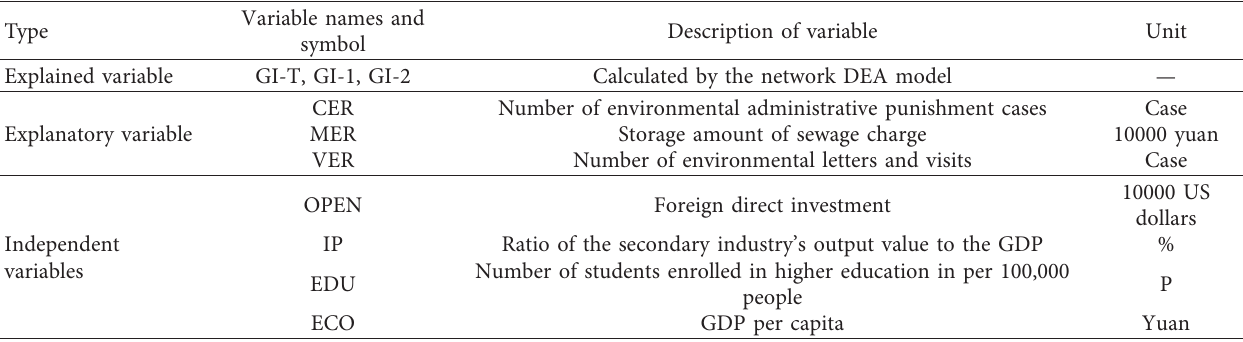
Table 2: Description of each variable.